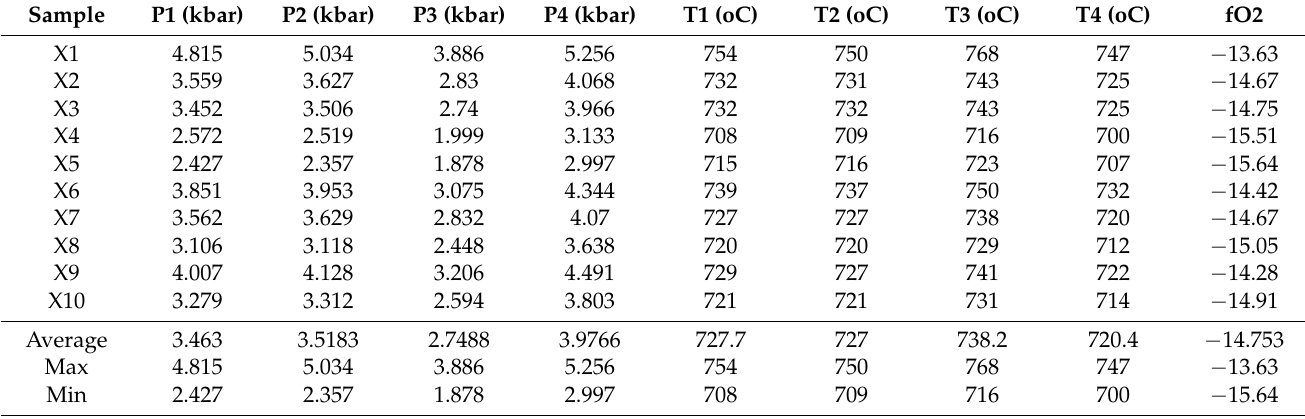
Table 6. Results of geothermobarometery and oxygen fugacity from amphibole in the diorite enclaves